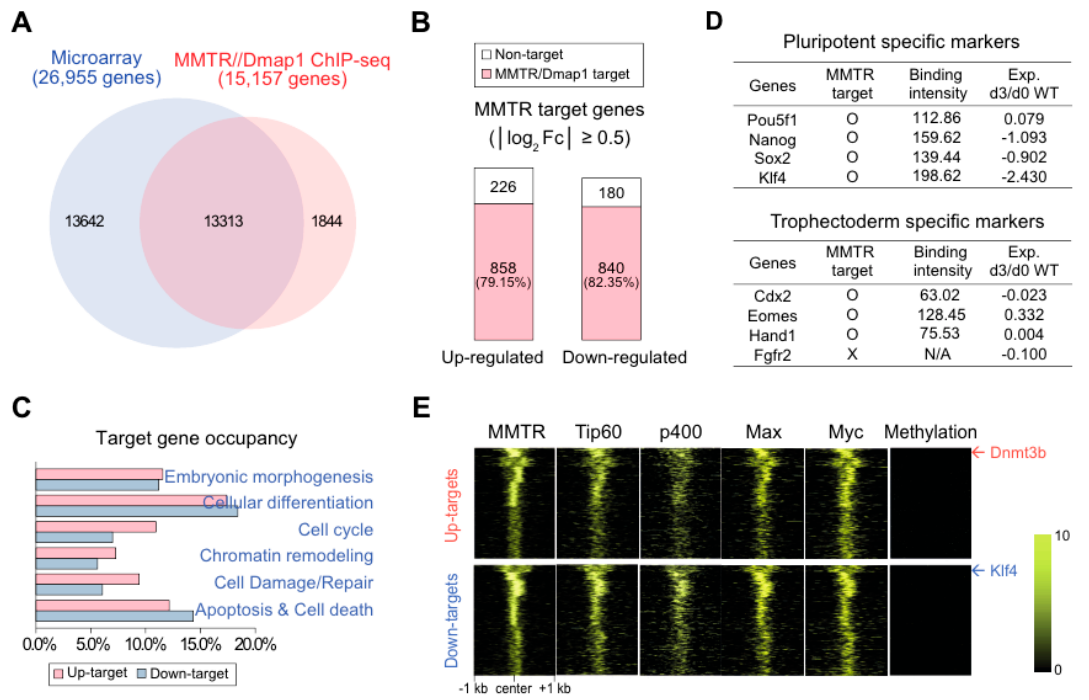
Figure 3. Alteration of MMTR/Dmap1 target gene expression during spontaneous mESCs differentiation. ( A ) Venn diagram of overlapping gene numbers at day 0 WT mESCs in the microarray and genes targeted by MMTR/Dmap1 in CHIP-seq (GSM1183112, TSS ≤ ± 20 kb). We indicated the number of overlapping and non-overlapping genes. ( B ) Percentage of MMTR/Dmap1 target genes among those with significant (|log 2 Fc| ≥ 0.5) up- or downregulation during spontaneous mESCs differentiation. ( C ) The mESC differentiation commitment-related gene ontology (GO) biological process in up- or downregulated MMTR/Dmap1 targets. ( D ) Dependency of expression change to pluripotency and trophectoderm targets of MMTR/Dmap1 during mESC differentiation. MMTR target = Binding intensity ≥ 60; Binding intensity = − log 10 ( p -value); Expression changes = log 2 fold change. ( E ) ChIP-seq heat maps showing occupancies of MMTR/Dmap1, Tip60, p400, Max, Myc, and the DNA methylation status in the promoters of MMTR/Dmap1 up- and down-target genes in undifferentiated mESCs. Dnmt3b and Klf4 are representative for MMTR/Dmap1 up- or downtarget genes, respectively. The color bar indicates binding strength. GO, gene ontology.